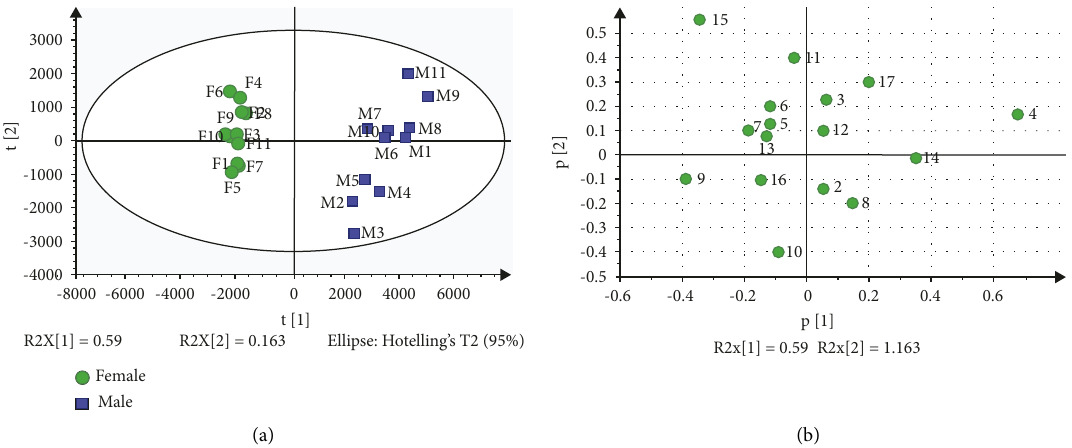
Figure 3: PCA score plot and loading scatter plot based on the peak areas of 17 common peaks of MFB and FFB of P. tomentosa . (a) Score plot of the PCA model. Boxes refer to MFB of P. tomentosa , and circles refer to FFB of P. tomentosa . The X axis refers to the scores of the first principal component (PC1). The Y axis refers to the scores of the second principal component (PC2). The variances accounted by PC1 and PC2 were 59.0% and 16.3%, respectively. (b) Loading scatter plot of the PCA